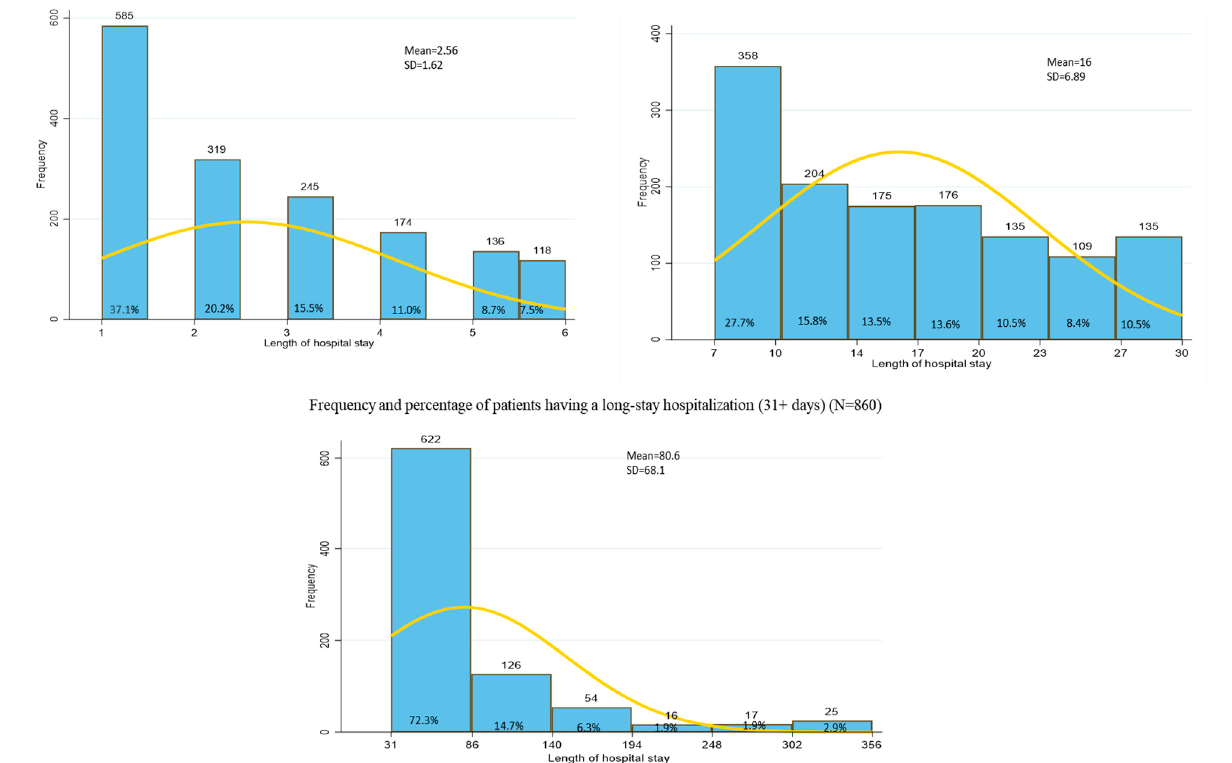
Figure 1. Distribution of length of hospital